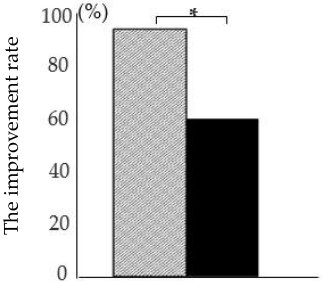
Figure 2. Alleviation of constipation by drinking RDSW or mineral water. In the study, 17 subjects (RDSW group) and 15 subjects (control group) reported constipation in the questionnaire. The constipation improvement rate was 94% and 60% in the RDSW group and control group, respectively. Hatched bar, RDSW group; black bar, control group; * p < 0.05.